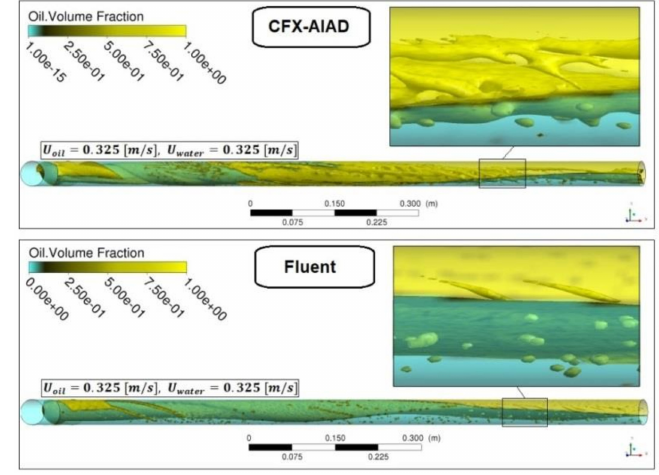
Figure 17. Oil volume fraction in the entire domain at U oil = 0.325 m / s, U water = 0.325 m / s. For the fourth case where U oil = 0.122 m / s and U water = 0.284 m / s, the experiment clearly shows a disperse flow pattern of small oil droplets in the aqueous phase (DO / W & W) (Figure 18). None of the two cases managed to capture the proper entrainment of droplets inside the liquid phase (Figure 19).